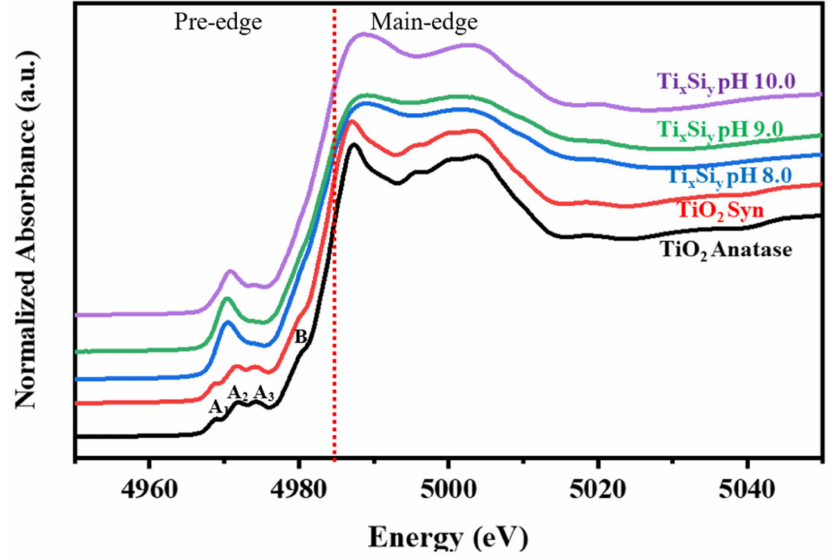
Figure 10. Ti K -edge XANES spectra of Ti 50 Si 50 oxide synthesized with pH 8.0, 9.0, and